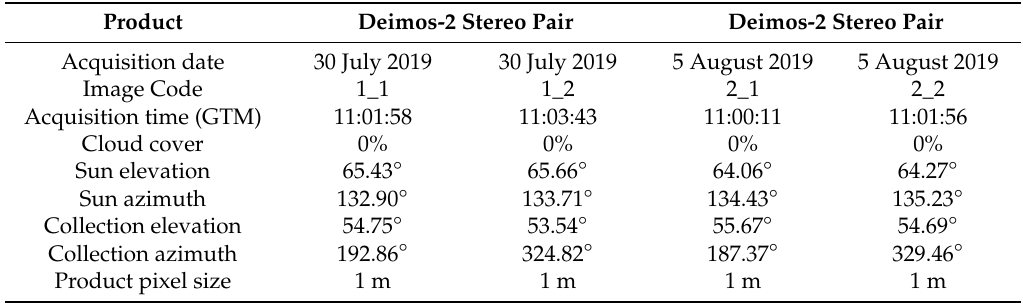
Table 1. Characteristics of panchromatic (PAN) images from Deimos-2 acquired at the study